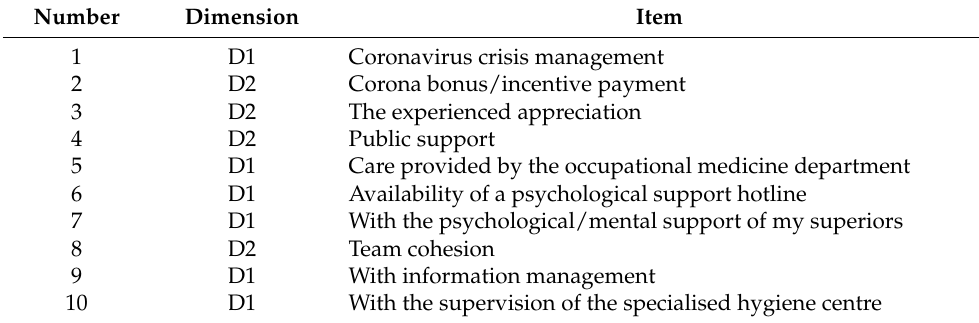
Table 12. Satisfaction Scale and